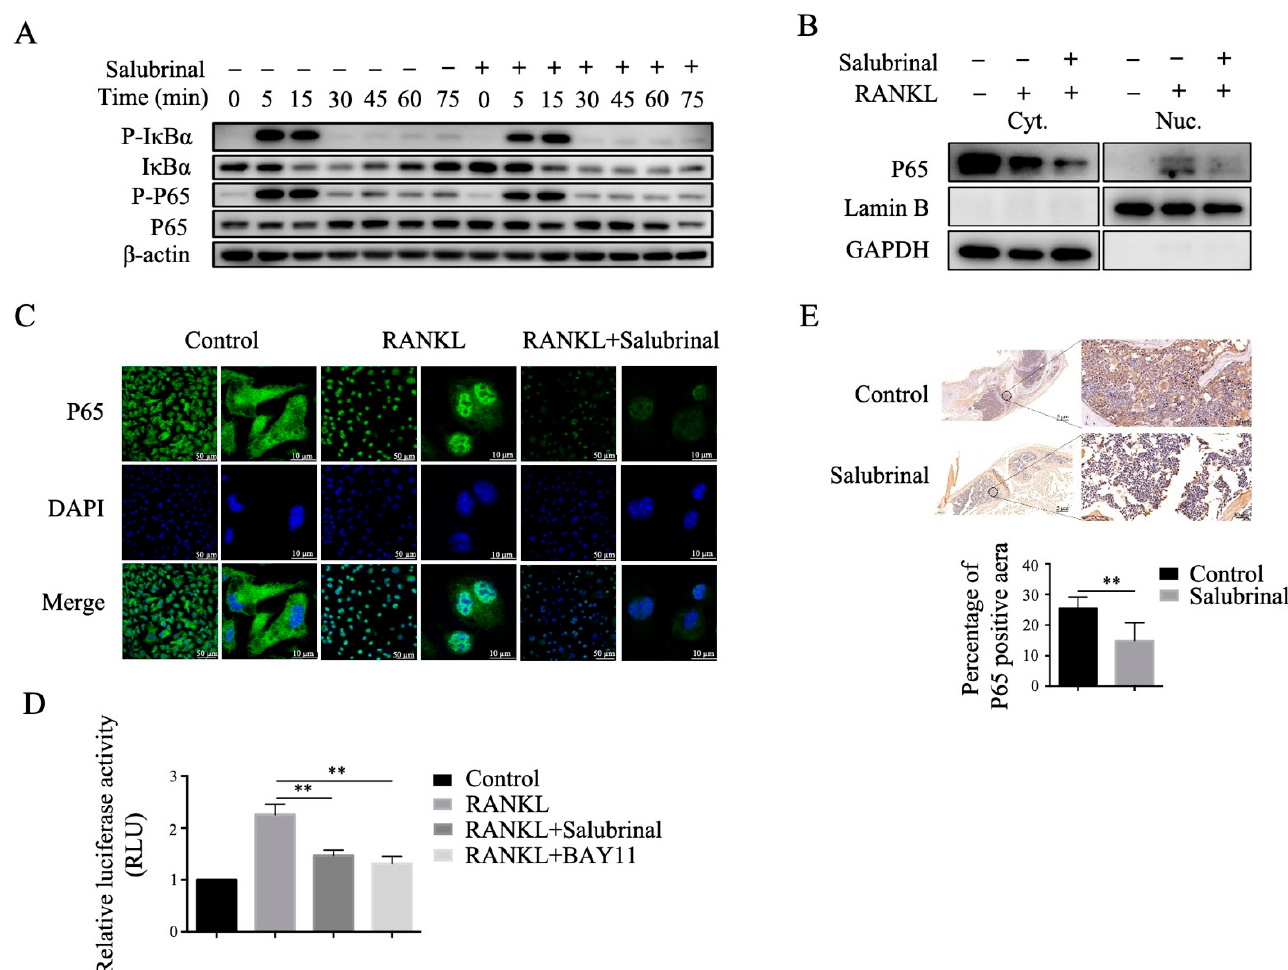
Figure 3. Salubrinal downregulated P65 abundance and inhibited the RANKL-induced NF- κ B signaling pathway. ( A ) Phospho-I κ B α , I κ B α , phospho-P65, and P65 expression levels were analyzed by Western blotting after stimulation with RANKL (30 ng/mL) for the indicated times in bone marrow-derived osteoclast precursors pretreated with Salubrinal (10 µM) for 3 h. P65 abundance in the nucleus and cytoplasm was analyzed by Western blotting ( B ) and immunofluorescence staining ( C ) after stimulation with RANKL (30 ng/mL) for 30 min in bone marrow-derived osteoclast precursors pretreated with Salubrinal (10 µM) for 3 h. ( D ) NF- κ B signaling transcriptional activity was measured using dual-luciferase reporter assays. ( E ) P65 abundance in knee joints of CIA mice was detected by immunohistochemical staining. Data are shown as means ± SEM. ** p < 0.01.